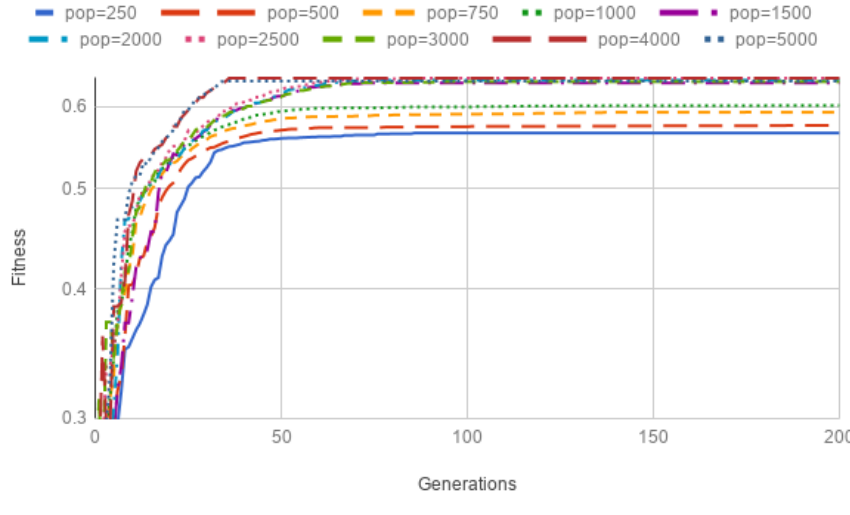
Figure 6. Evolution of maximum fitness values for different initial